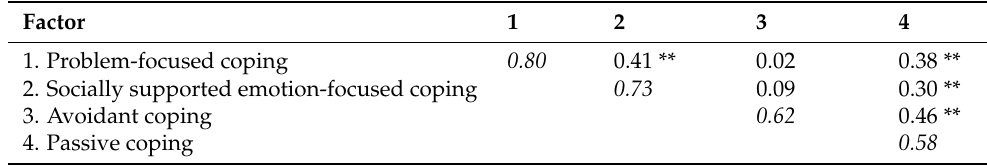
Table 4. Factor correlation matrix.